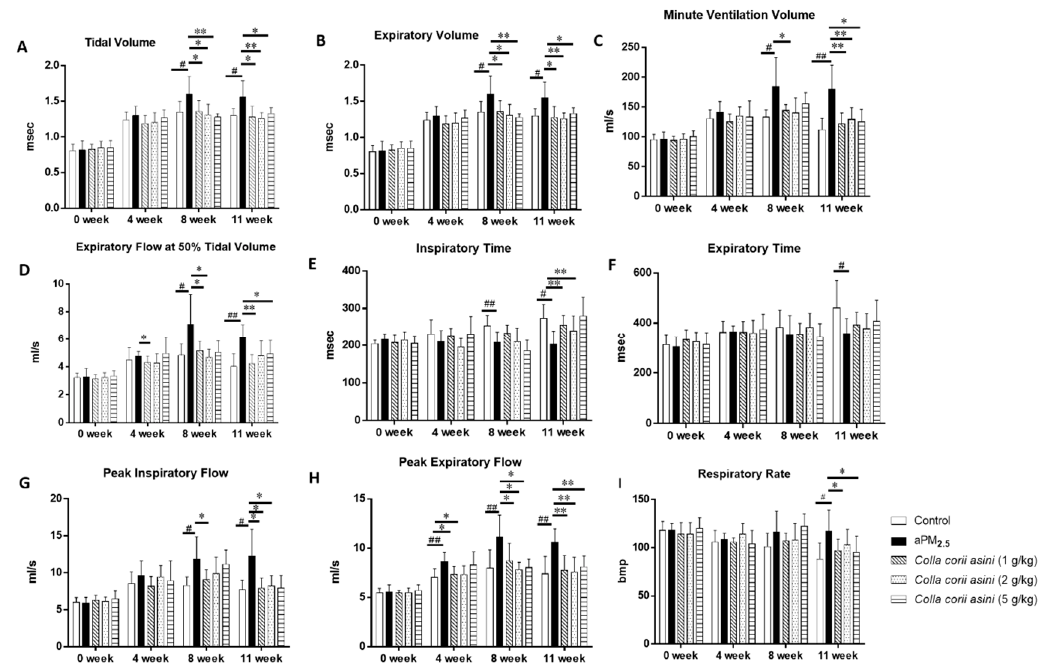
Figure 1. Protective effect of Colla corii asini in rats subjected to intratracheal instillation of aPM 2.5 . ( A – I ) Respiratory function changes of rats during intratracheal instillation of aPM 2.5 for 11 weeks. ( A ). Tidal volume and ( B ). Expiratory volume (msec). ( C ). Minute ventilation volume. ( D ). Expiratory flow at 50% tidal volume (mL). ( E ). Inspiratory time and ( F ). Expiratory time (msec). ( G ). Peak inspiratory flow. ( H ). Peak expiratory flow (mL/s). ( I ). Respiratory rate (bmp). # p < 0.05 and ## p < 0.01, versus the